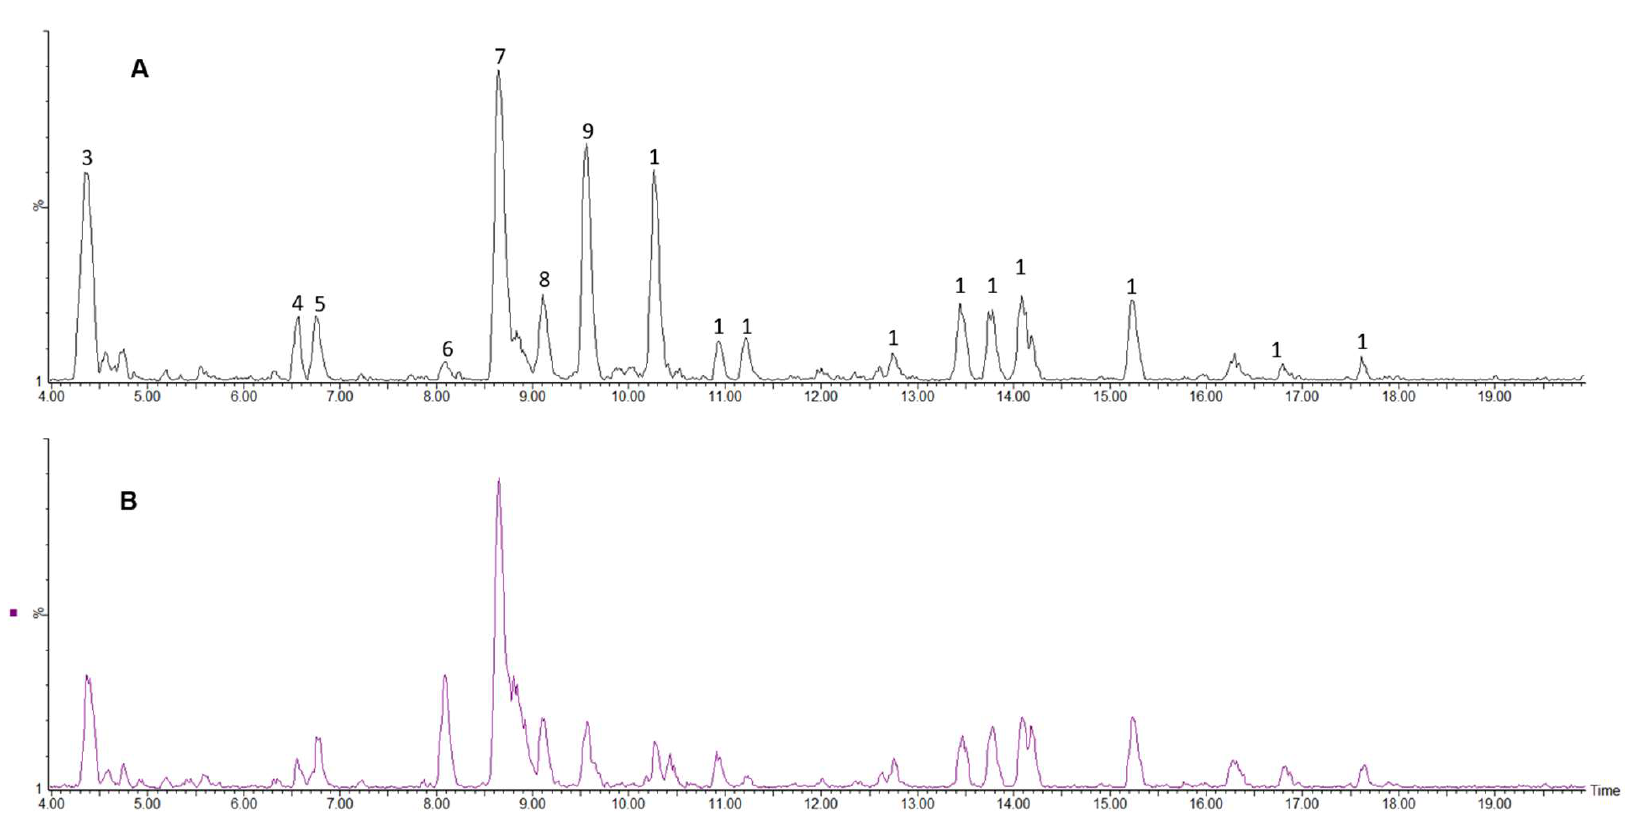
Figure 4. Comparison of TIC chromatograms at di ff erent ripening stage: ( A ) Ripening stage 1 (RS1) and ( B ) ripening stage 2 (RS2) (MS E F1: low-energy